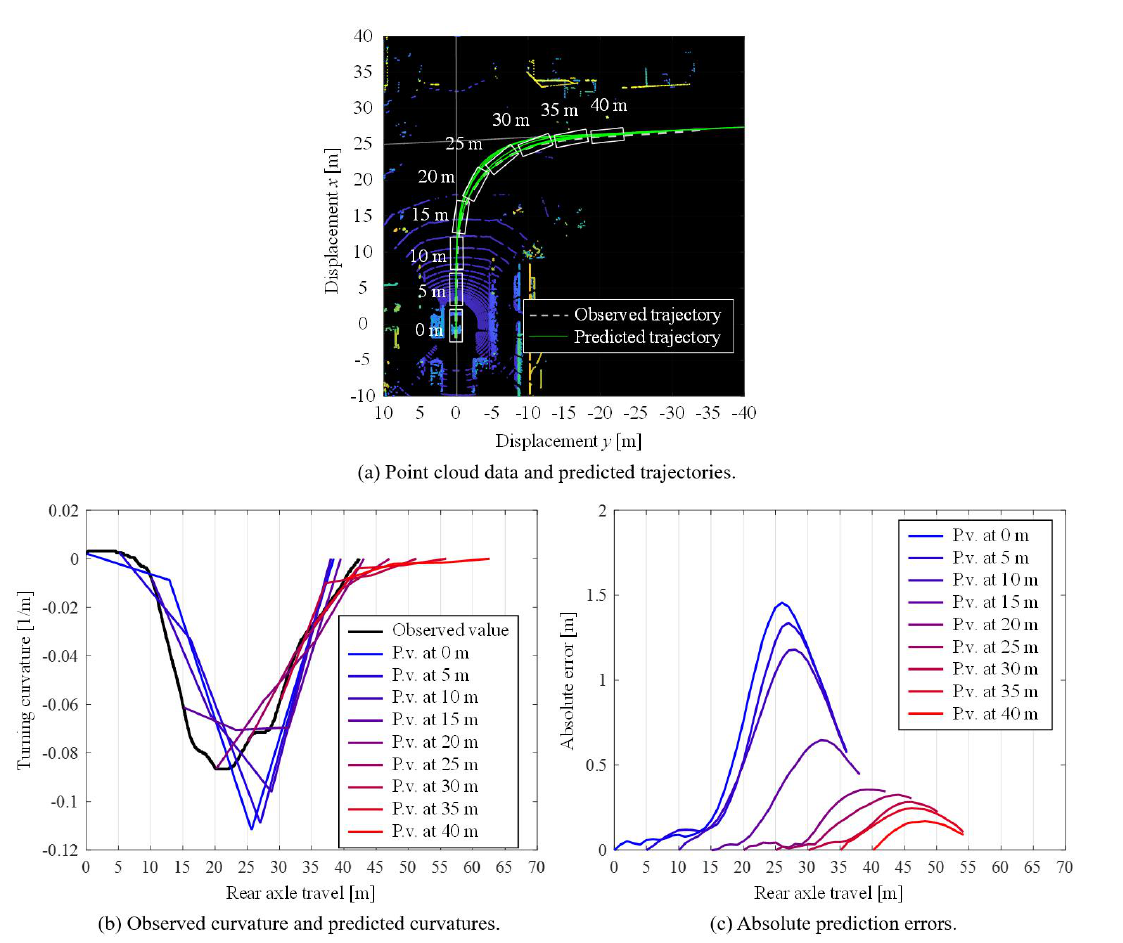
Figure 11. Prediction results with estimated distance parameter ˆ d pre from experiment at intersection ID 2-1 (P.v. in the legends in the figures stands for predicted value. Absolute errors refer to the deviation of the predicted vehicle rear axle trajectory in the curvilinear normal direction with respect to the actual measured driving